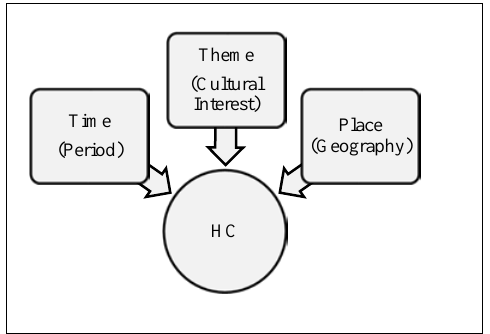
Figure 4. Parameters of the Historic Context